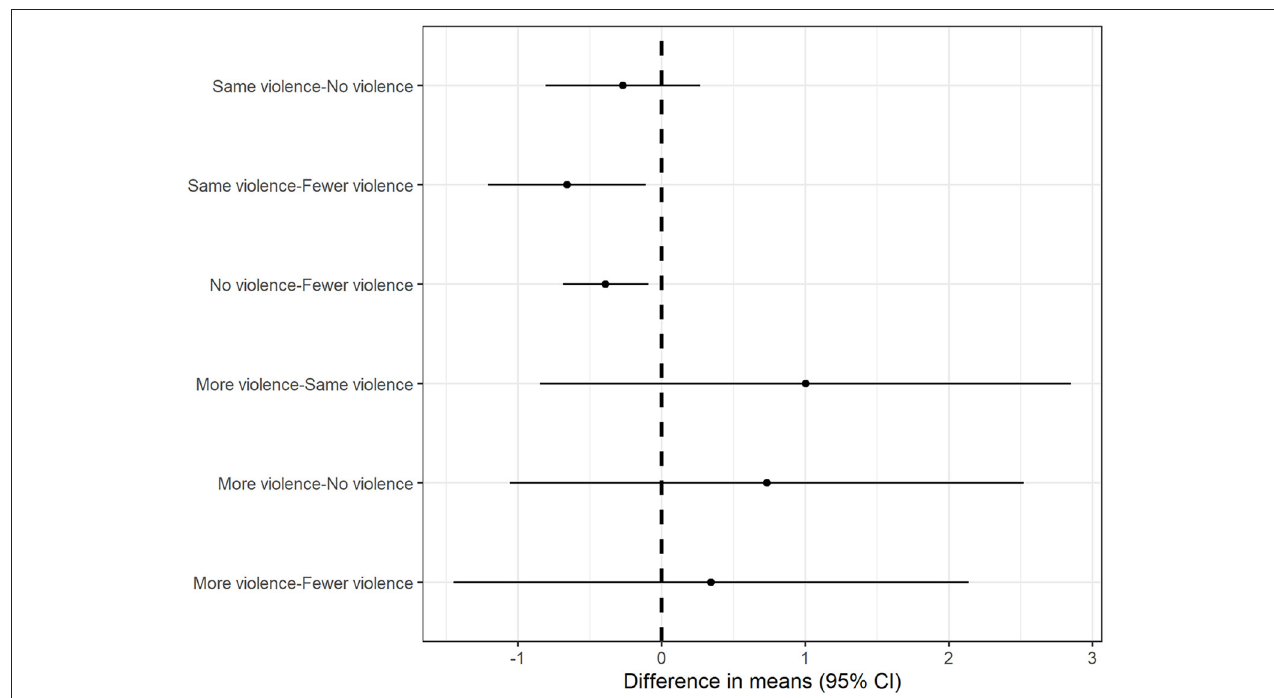
FIGURE 4 | Marginal mean differences in DPR for verbal abuse. Individuals with fewer other-perceived verbal abuse had greater DPR score compared to individuals with either same or no verbal